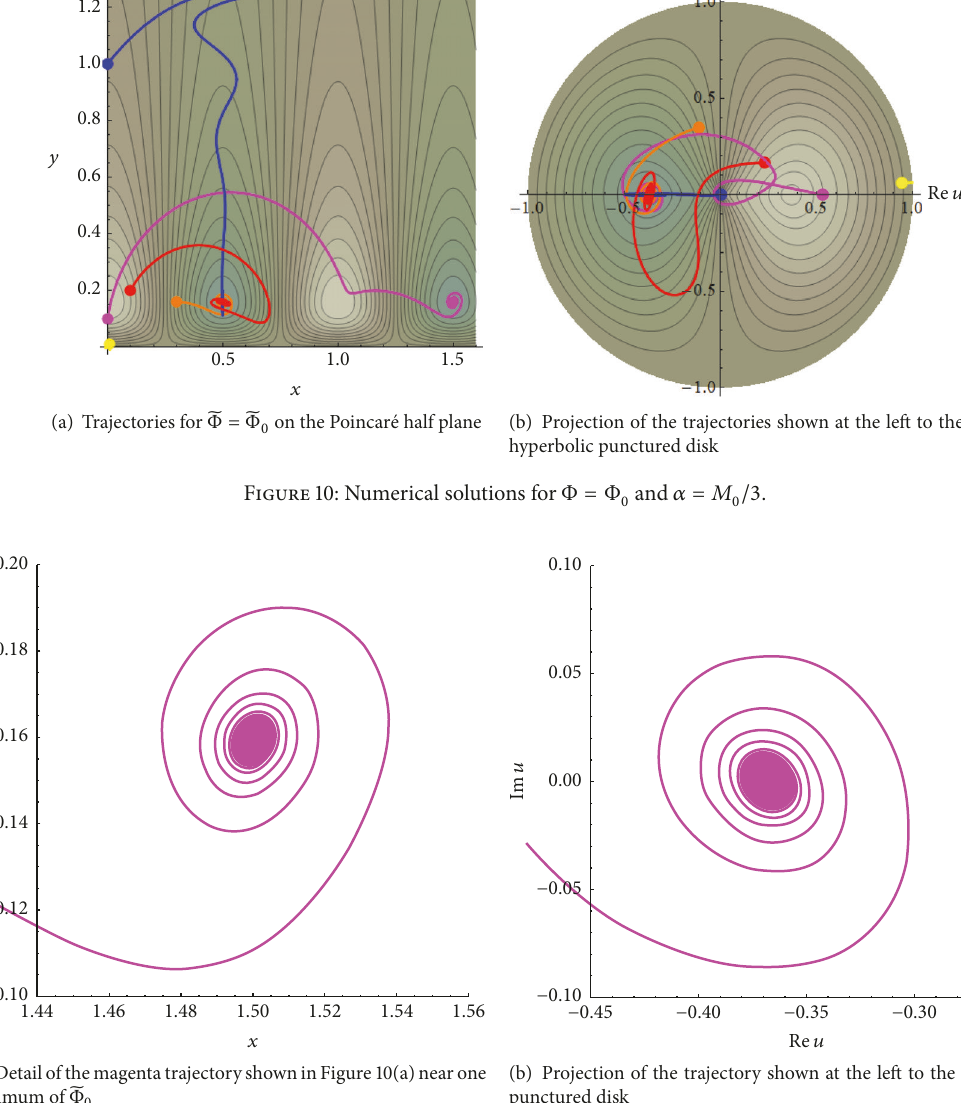
Figure 11: Detail of the magenta